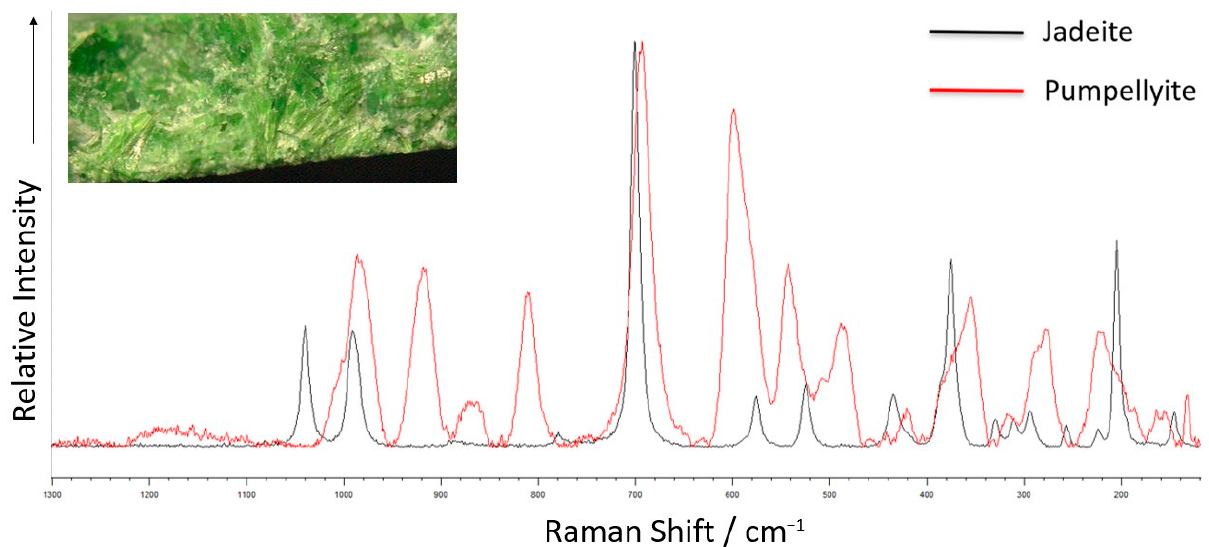
Figure 6. Overlap of jadeite (acquired by In-Via Confocal micro-Raman Spectroscope, Renishaw, 514.5 nm source by the author on GECI Reference stones collection); black line and pumpellyite (re-plotted from RRUFF N. R120172 [135]); red line, Raman spectra with baseline subtraction. The spectra have been elaborated by Wire 5.5 software. The top-left box shows the OM (5× magnification, darkfield) of a cabochon section of jadeite-pumpellyite association in albite matrix.